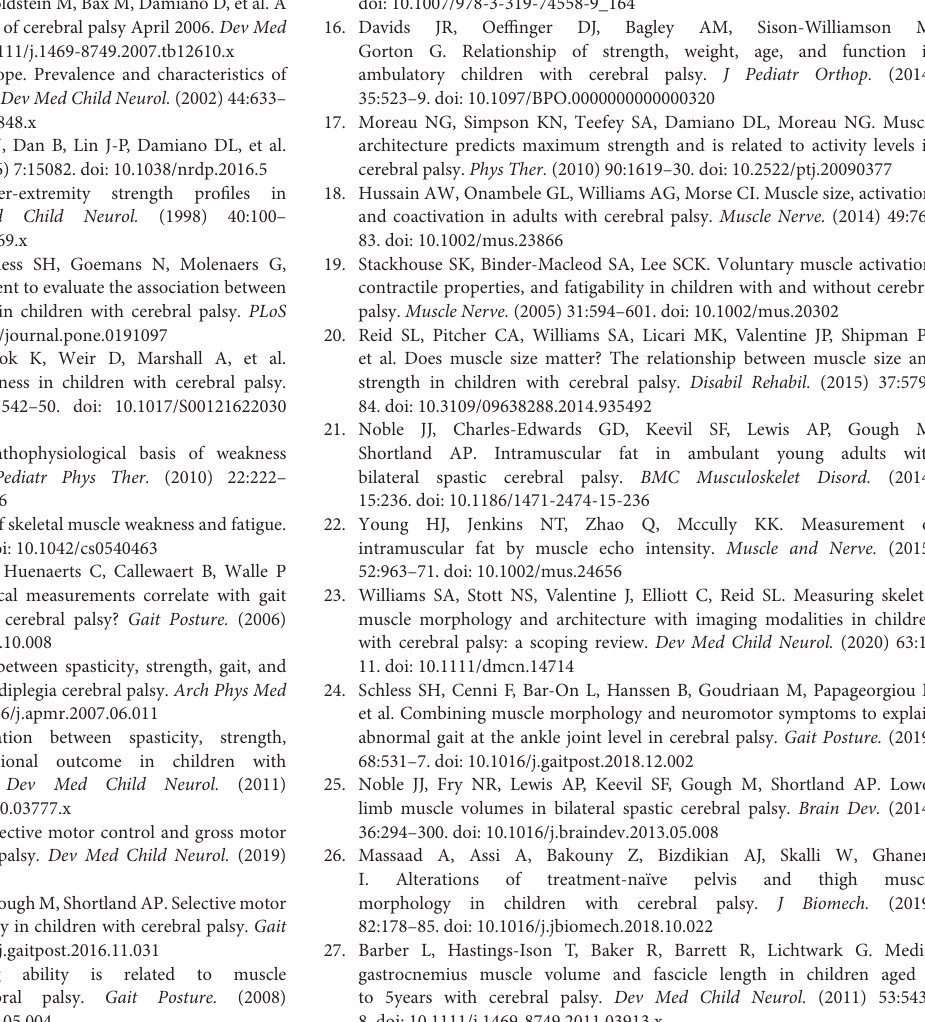
Supplementary Figure 1 | Display of the measured and estimated maximal joint torques (MJT)s per participant. The blue bar indicates the MJT measured , the red part is the deficit to MJT norm due to decreased muscle volume (MV,) and the orange part of the graph indicates the deficit in MJT that comes from other factors than the decrease in MV. A negative red bar indicates an MJT potential based on MV that is larger than expected from growth. A negative orange bar indicates an MJT measured that is larger than expected based on MV. For all four joint movements, the bars on the x-axis are ranked from smallest to tallest child (in height), resulting in the same order of children for all four